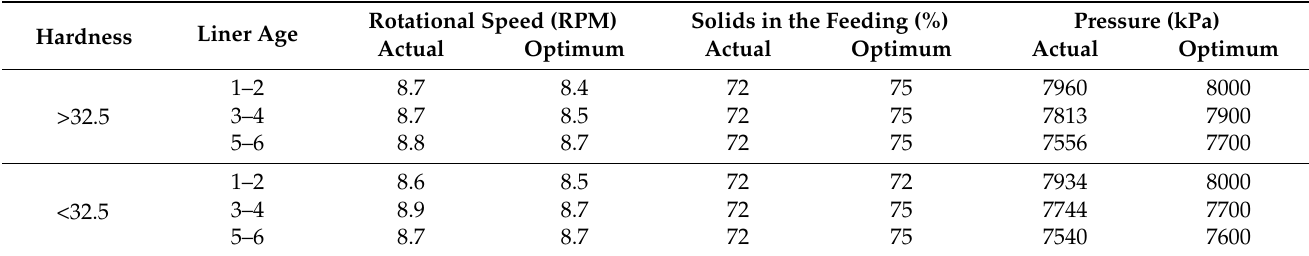
Table 3. Optimal operating guidelines for the SAG mill.